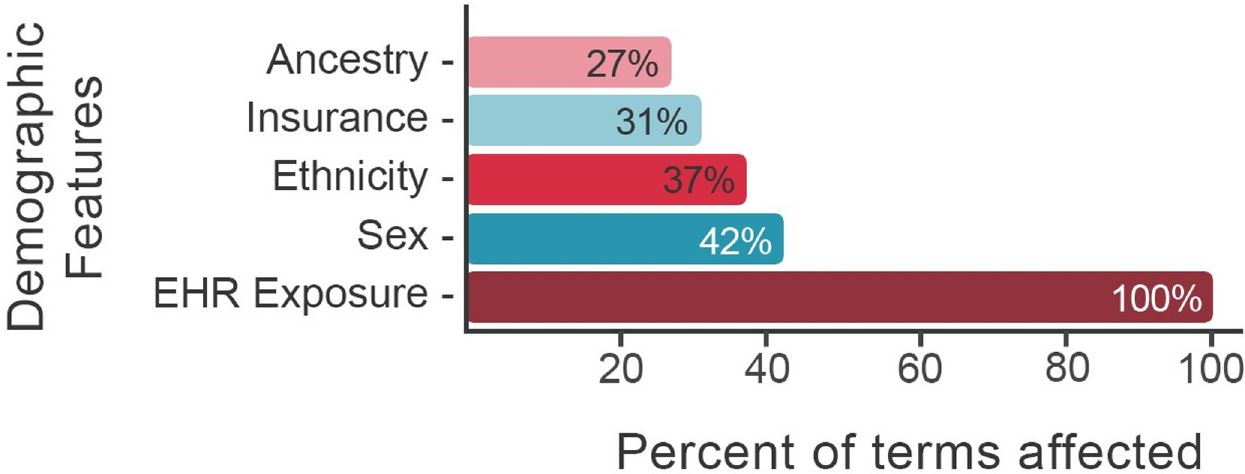
Fig 1. Percent of medical terms influenced by various demographic features. Demographic variables used in the comorbidity discovery process are displayed on the y-axis. The percent of all diagnoses, procedures, and medications influenced by a given demographic feature is displayed on the x-axis. For example, sex influences 42.2% percent of diagnoses, procedures, and medications in the Utah EHR corpus; ancestry influences 27.4% and EHR exposure 100%. EHR exposure includes subject age, length of medical record history, number of visits. See article [10] for details. Features were selected using L1 regularization.